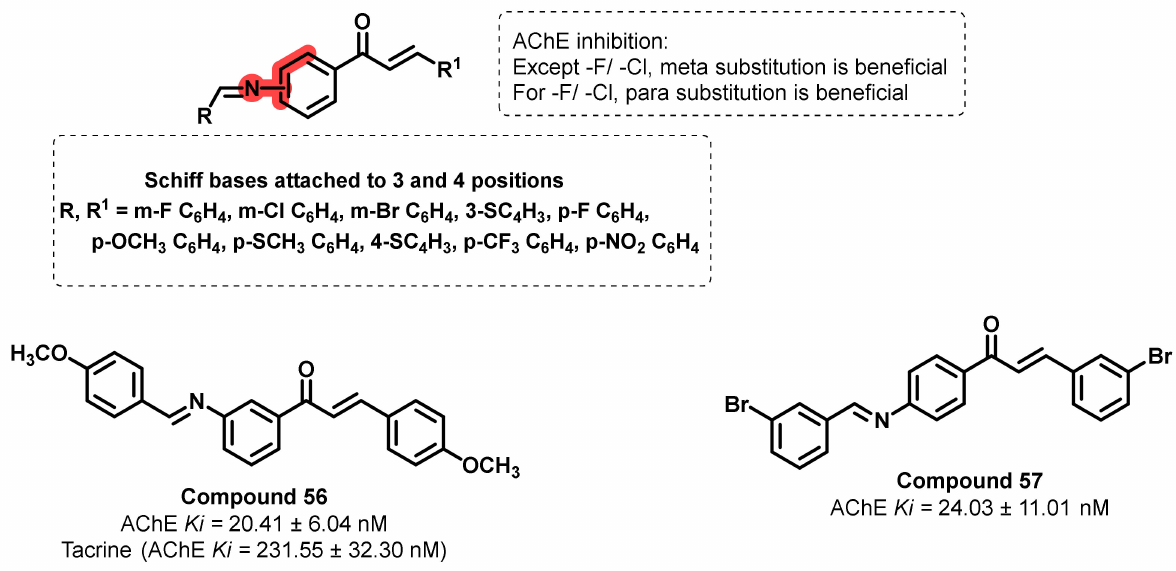
Figure 46. Chemical structures of Schiff bases-appended chalcone